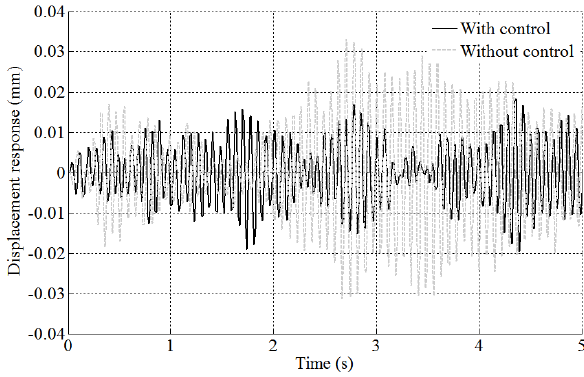
Figure 7: The tip deflection of the beam under random